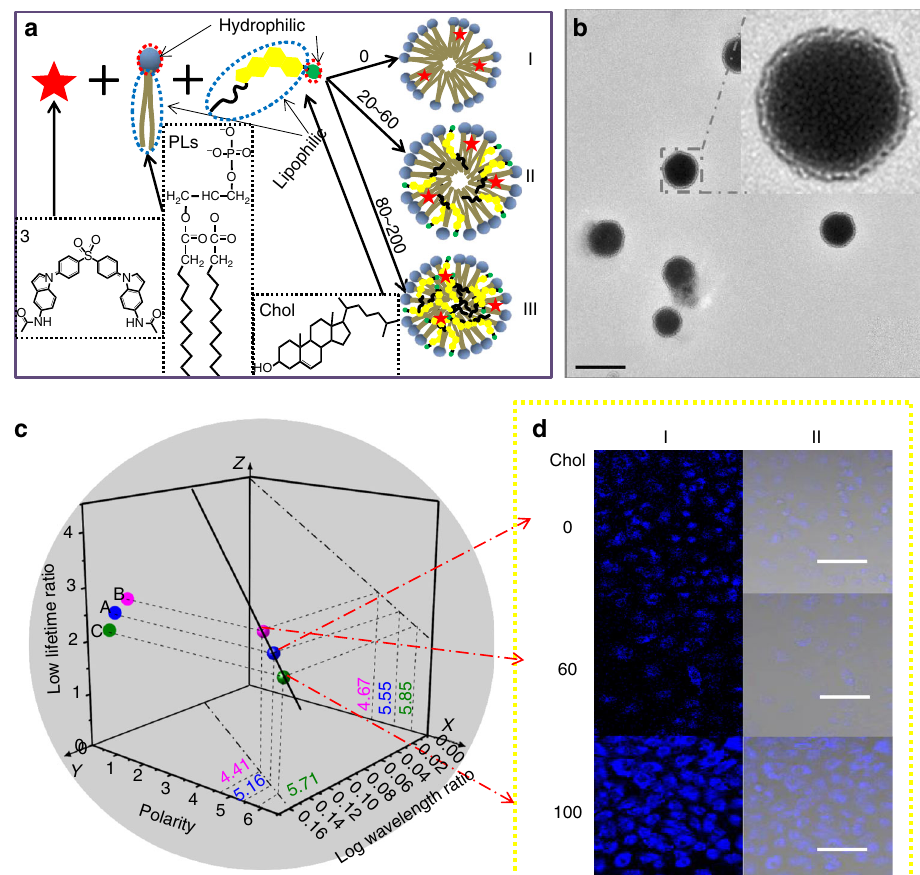
Fig. 5 Application of the 3-D ratiometric luminescent sensing strategy in simulated membranes. a Schematic illustration of the complex PLs systems with different Chol contents. b TEM image of the PLs systems (inset: a zoom-in image). Scale bar, 200 nm. c 3-D plot diagram based on the single emitter 3. The points represent the luminescent behaviors with different Chol contents in the complex PLs system, thus for deducing the corresponding polarity values. d Confocal fl uorescence microscopy imaging of Hela cells incubated with the complex PLs system with different Chol contents of 0, 40, and 100. І , luminescence imaging and П , merged luminescence and bright- fi eld imaging collected by the 4 ’ ,6-diamidino-2-phenylindole (DAPI) channel ( λ ex = 408 nm). Scale bar, 50 µ m. PLs, phospholipids; Chol,